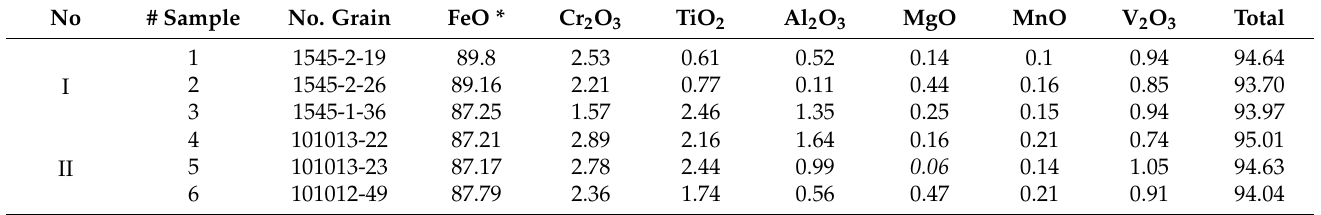
Table 4. Chemical composition of primary interstitial magnetite in clinopyroxenites I and II (in